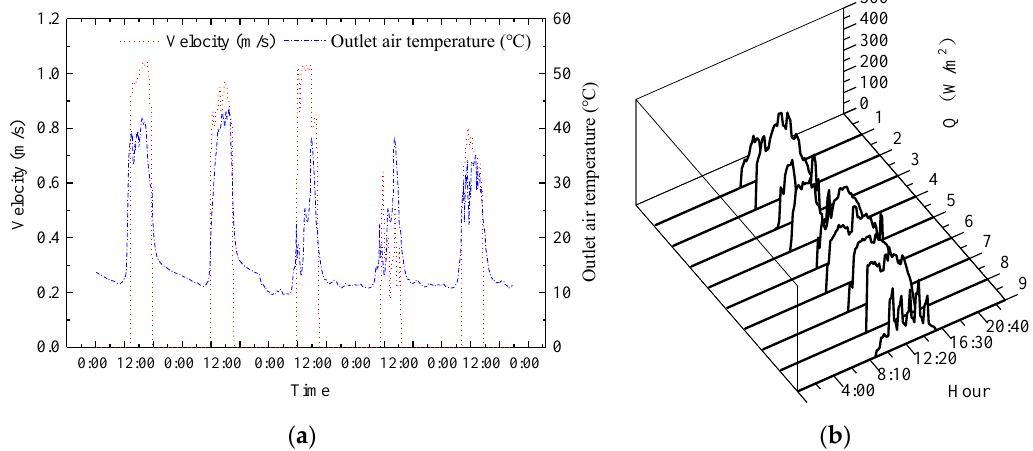
Figure 7. ( a ) Outlet air temperature and air velocity of the collector ( b ) Heat output of the solar wall.